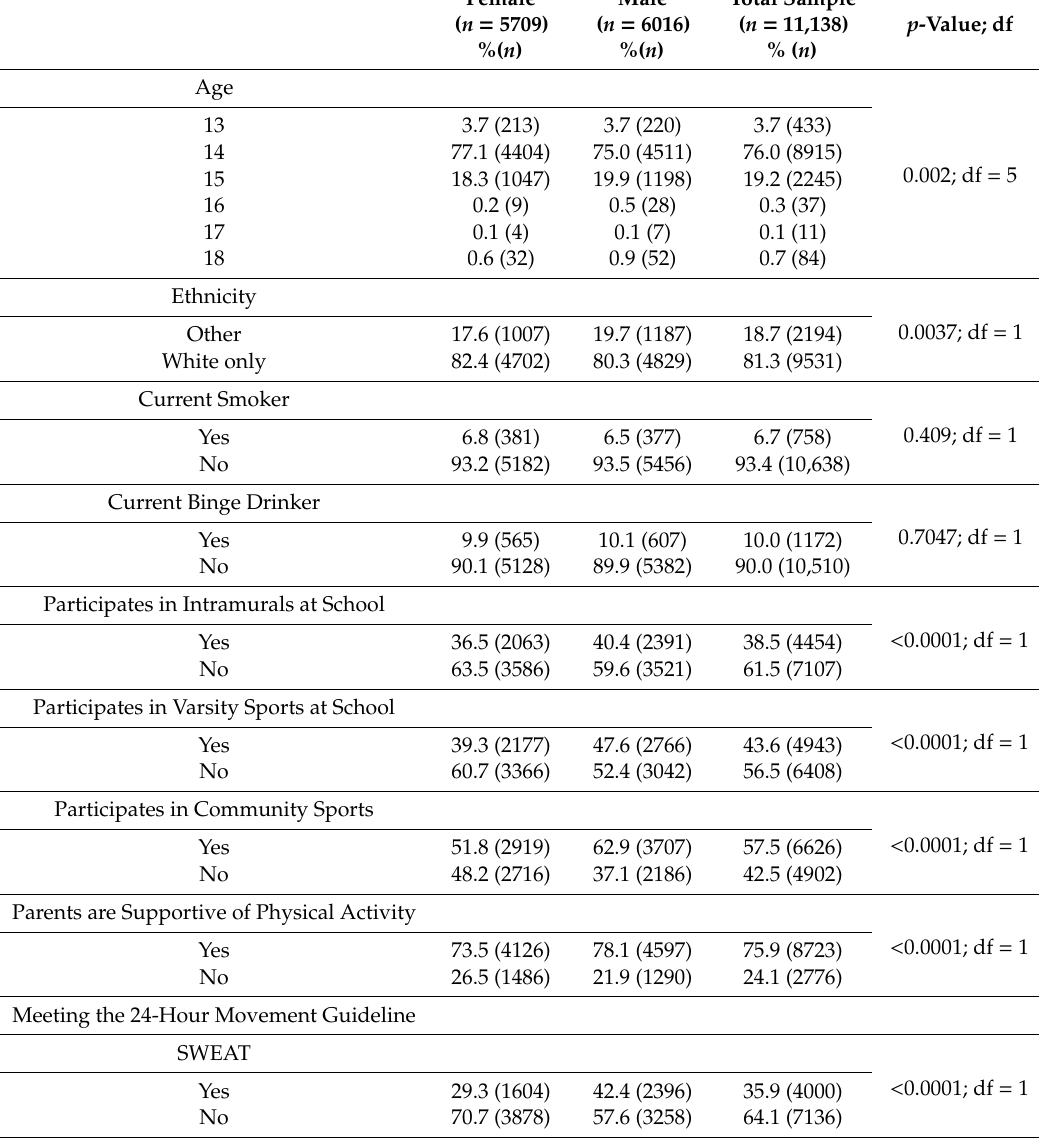
Table 1. Descriptive statistics for the cross-sectional COMPASS Year 2 (2013–2014) grade 9 student sample. BMI, body mass